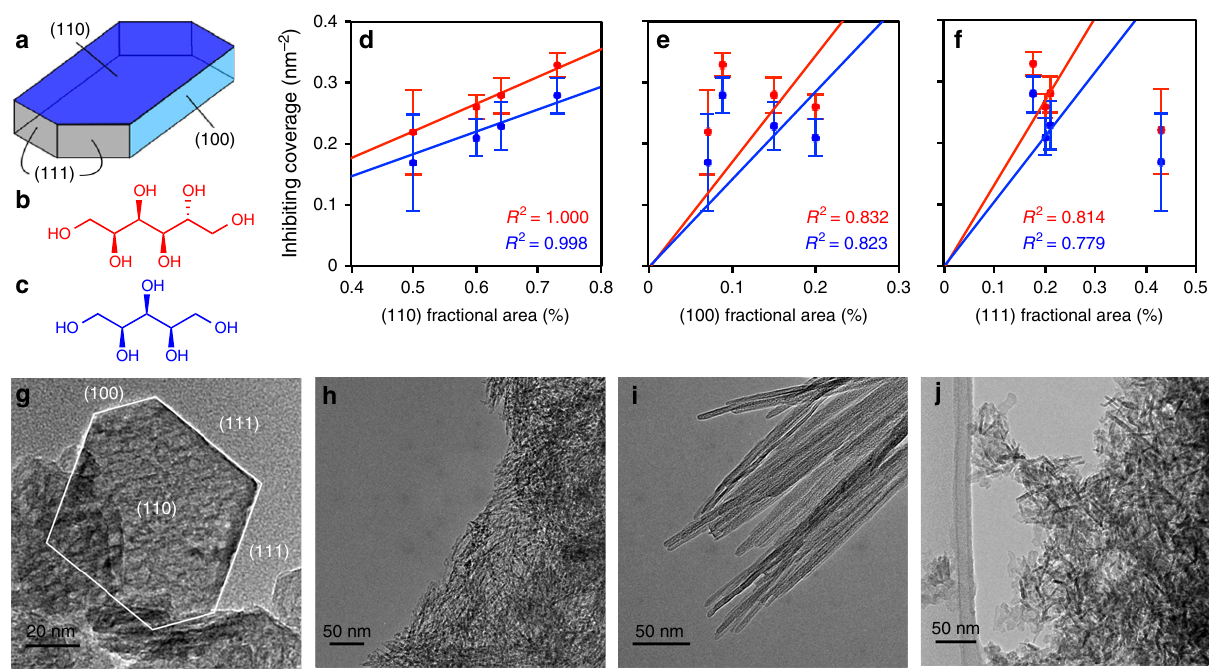
Fig. 1 Implication of the (110) facet in the decomposition of γ -Al 2 O 3 . a General topology of a γ -Al 2 O 3 nanoparticle exhibiting three major facets: (110) in dark blue, (100) in light blue and (111) in gray. b , c Structures of two inhibitors: b , sorbitol (red) and c , xylitol (blue). d , e , f Comparisons between the inhibiting coverage (sorbitol in red, xylitol in blue) and the fraction of exposed (110) ( d ), (111) ( e ), and (100) ( f ) surface areas. The experimental data sets are fi tted to the zero-intercept linear model derived in Supplementary Note 4. The fi tted curves are represented as straight lines. A correlation could only be established in the case of the (110) surface ( d ) with slopes of 0.367 ± 0.009 and 0.443 ± 0.005 nm − 2 for xylitol and sorbitol, respectively ( R 2 > 0.99). Error bars are calculated from high-performance liquid chromatography (HPLC) analysis standard deviation (see Supplementary Note 3). g , h , i , j Transmission electronic microscopy images of the four differently shaped γ -Al 2 O 3 nanoparticles ordered in increasing (110) fractional area: plates ( g ), fi bers ( h ), rods ( i ), and commercial γ -Al 2 O 3 ( j